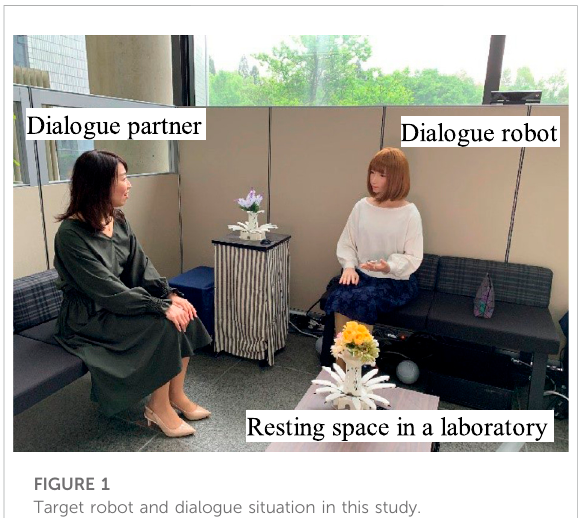
FIGURE 1 Target robot and dialogue situation in this